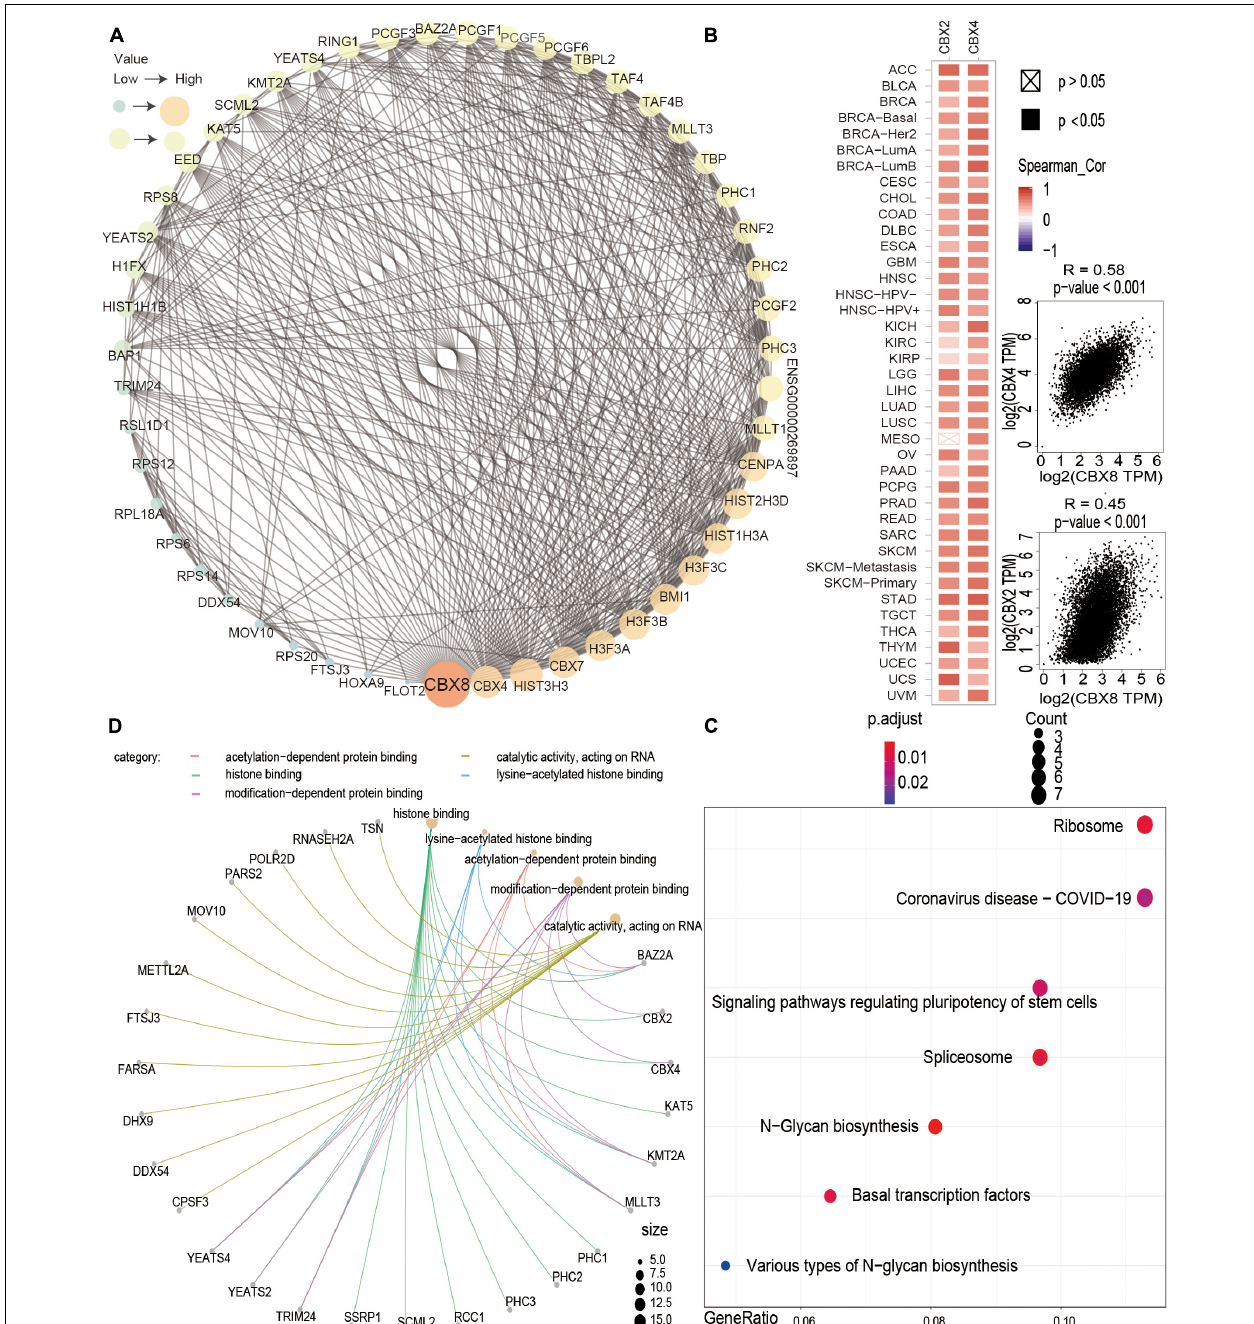
FIGURE 6 | CBX8-related gene enrichment analysis. (A) The top 50 CBX8-binding proteins were experimentally determined via the STRING tool and visualized by a molecular interaction network. (B) The top 100 CBX8-correlated genes in TCGA projects were obtained via the GEPIA2 tool, and the expression correlation between CBX8 and selected targeting genes, including CBX2 and CBX4, was analyzed. The corresponding heatmap data are displayed for the selected cancer types. (C) KEGG pathway analysis based on CBX8-binding and interacting genes. (D) GO analysis (molecular function data) based on CBX8-binding and interacting genes.